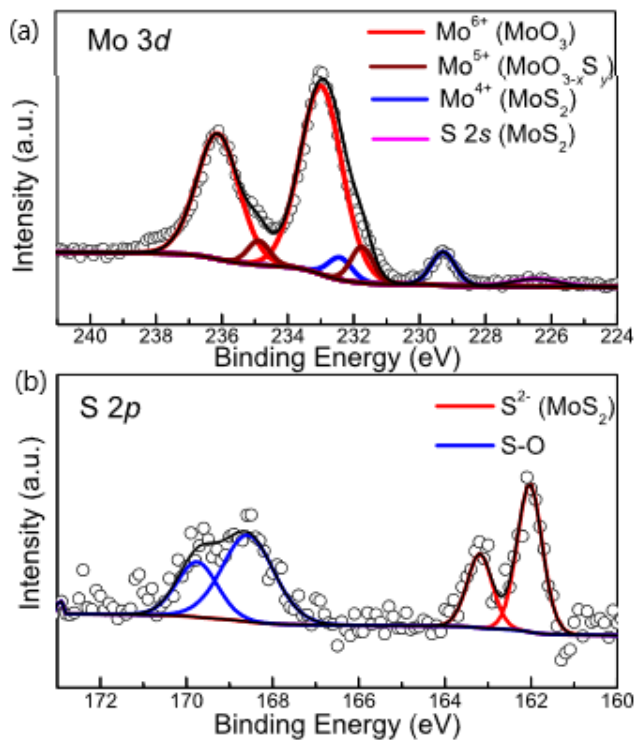
Figure 5. XPS spectra of ( a ) Mo 3 d core-levels and ( b ) S 2 p core-levels of sulfurized MoO 3 on SiO 2 /Si substrate.